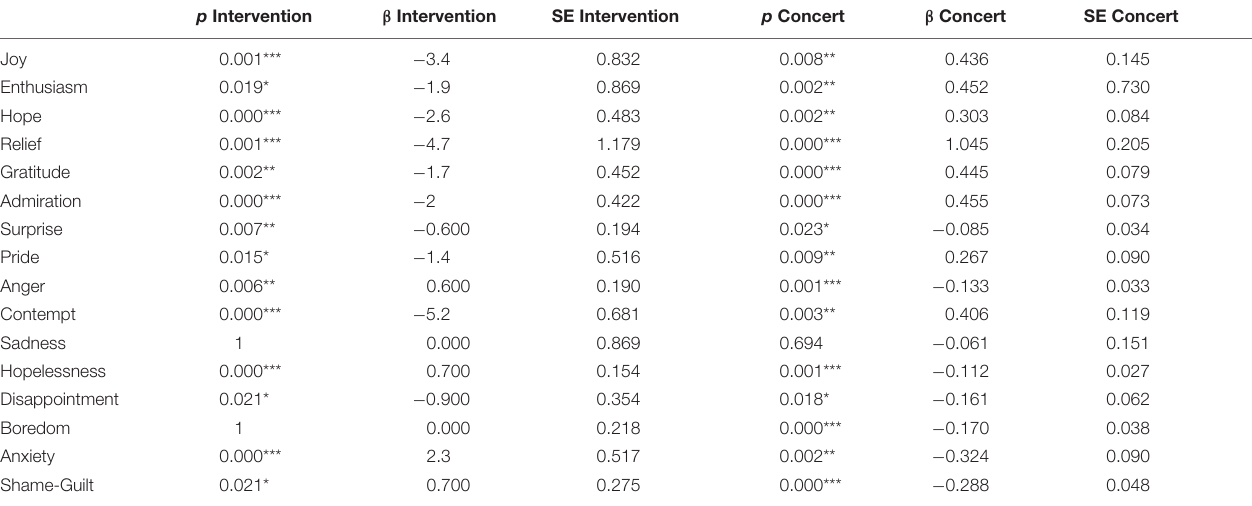
TABLE 1 | Effect of intervention and concert on positive and negative